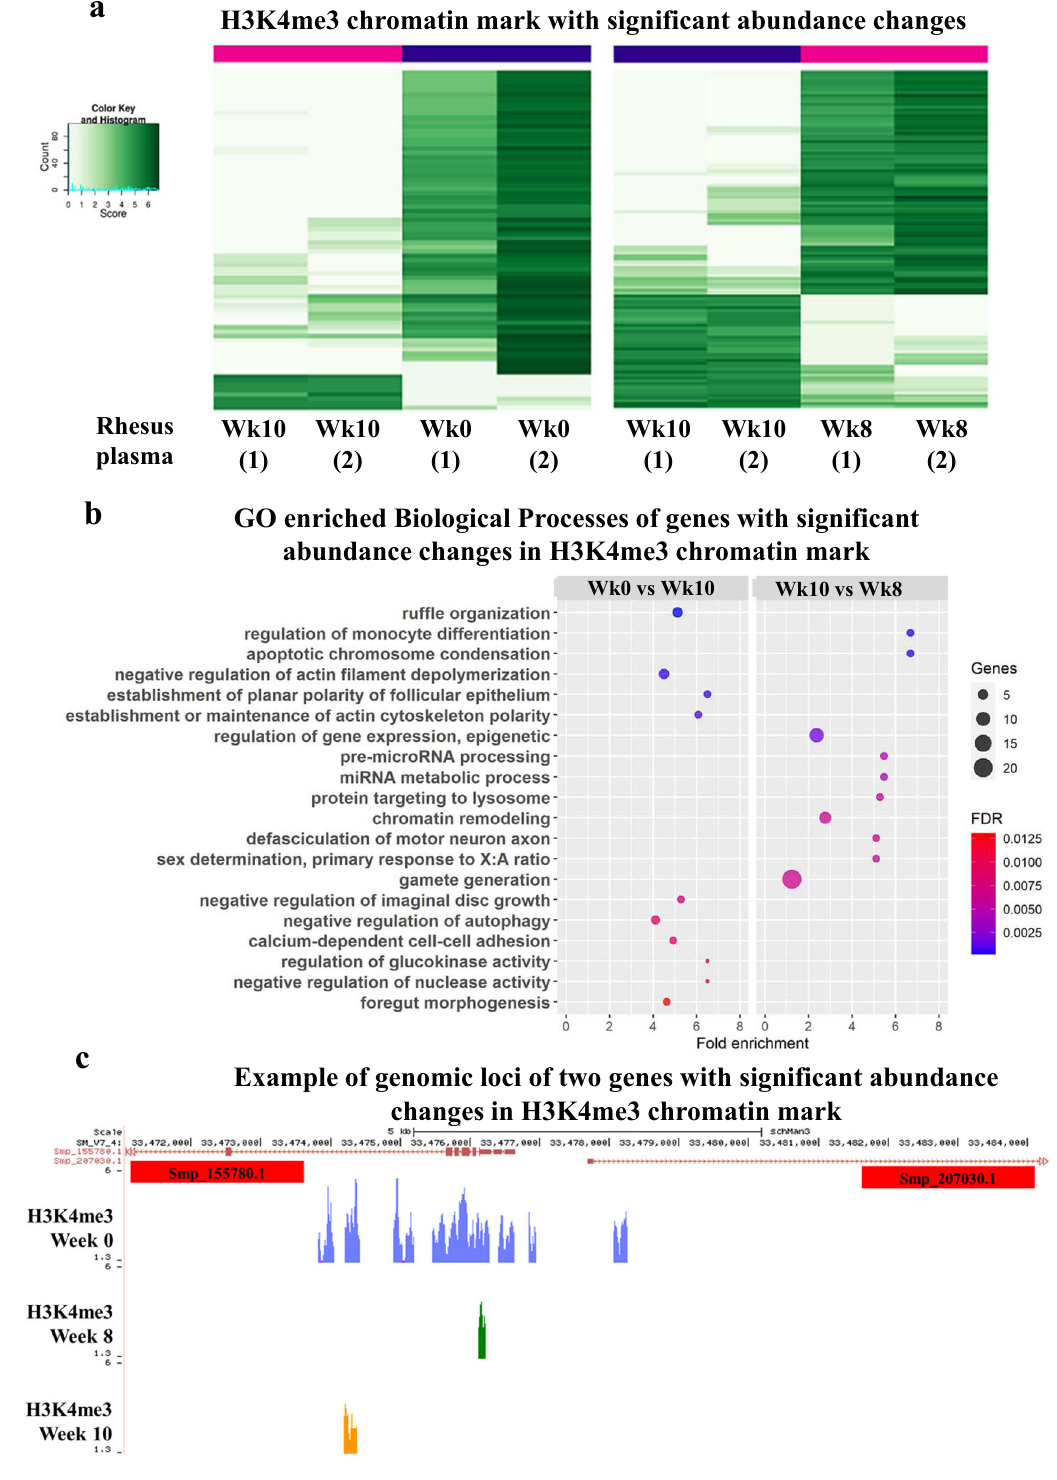
regulation of gene expression and chromatin remodelling (Fig. 8b, right and Supplementary Data